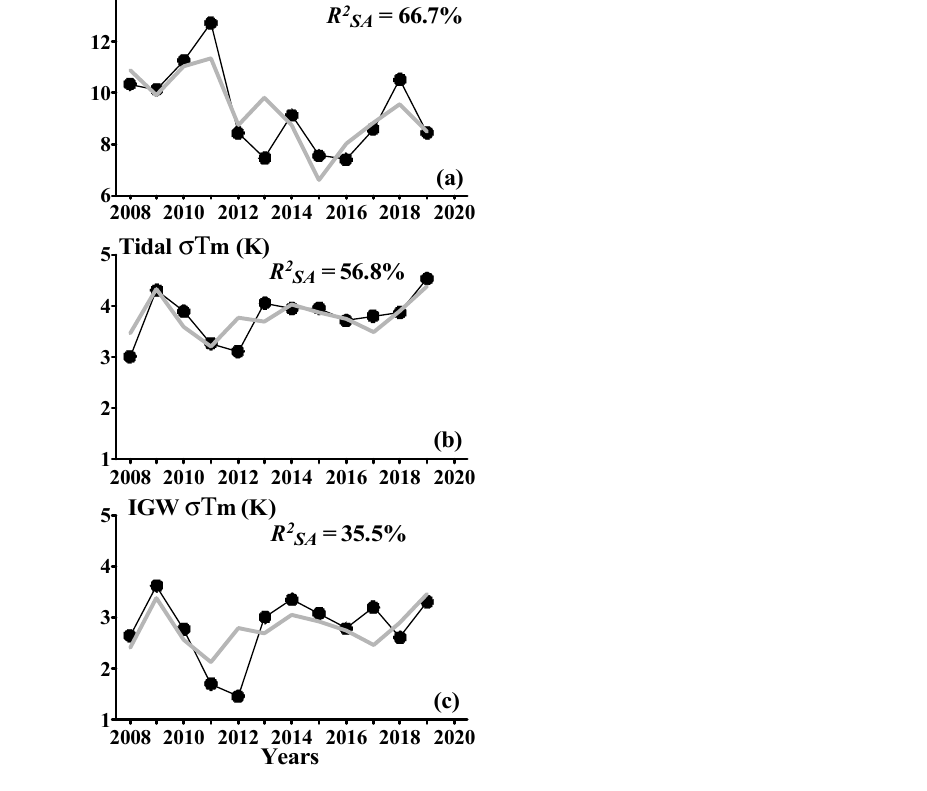
Figure 7. Year-to-year variations in σ Tm (black circle line) and their approximation by the multiple regression on SOI and Ap (grey). The day-to-day ( a ), tidal ( b ), and IGW ( c ) variability are presented from top to bottom.